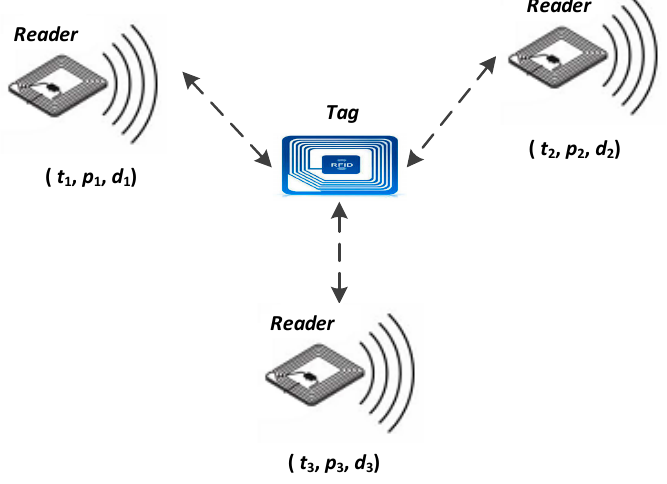
Figure 2. Snapshot of RFID tag location process.